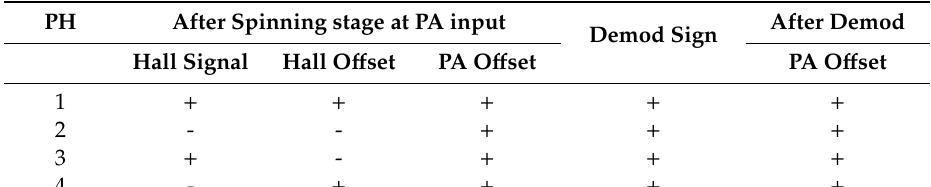
Table 4. Demodulation key applied on the amplified spinning output for the extraction of the amplification stage o ff set.